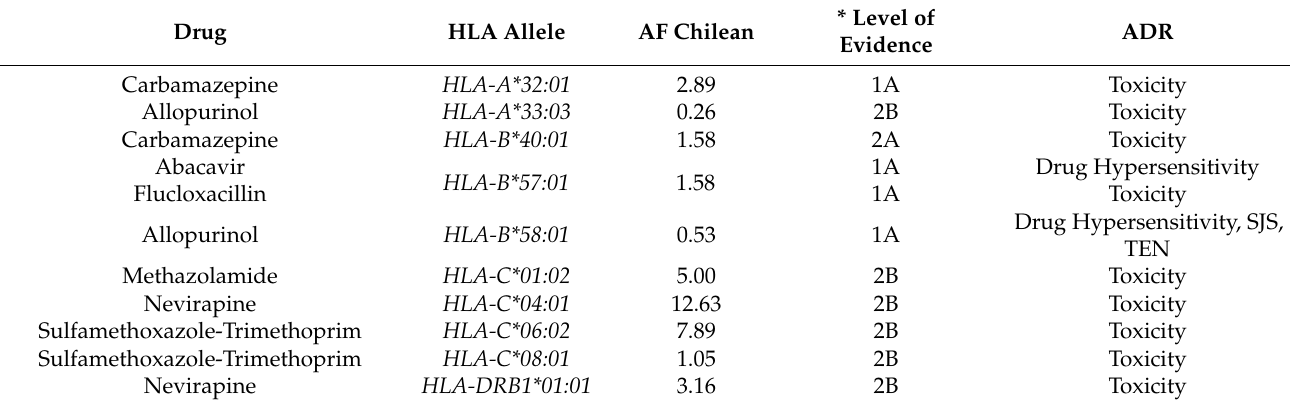
Table 3. List of Adverse drug reactions-related HLA alleles and drugs.